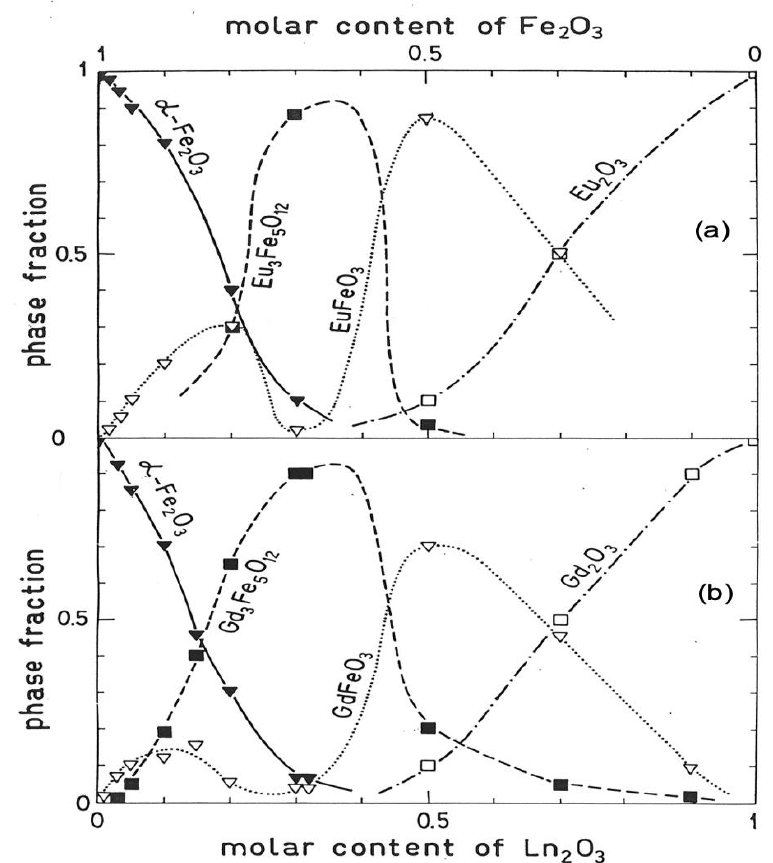
Figure 6. Approximate molar fractions (at RT) of the crystalline phases in the systems α -Fe 2 O 3 –Ln 2 O 3 , Ln = Eu ( a ), Gd ( b ), as a function of the initial molar fractions of α-Fe 2 O 3 and Ln 2 O 3. Samples were